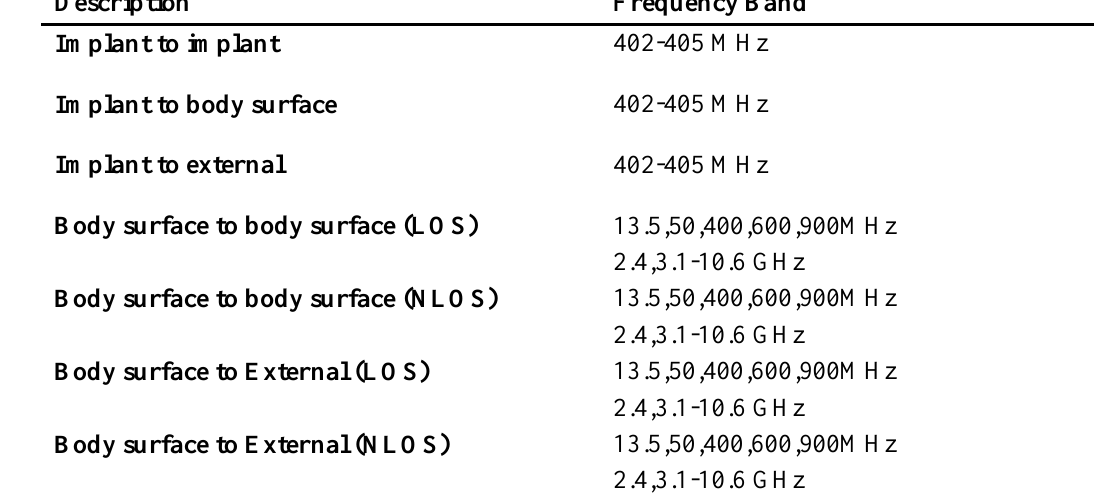
Table 6. Channel characterization on-body